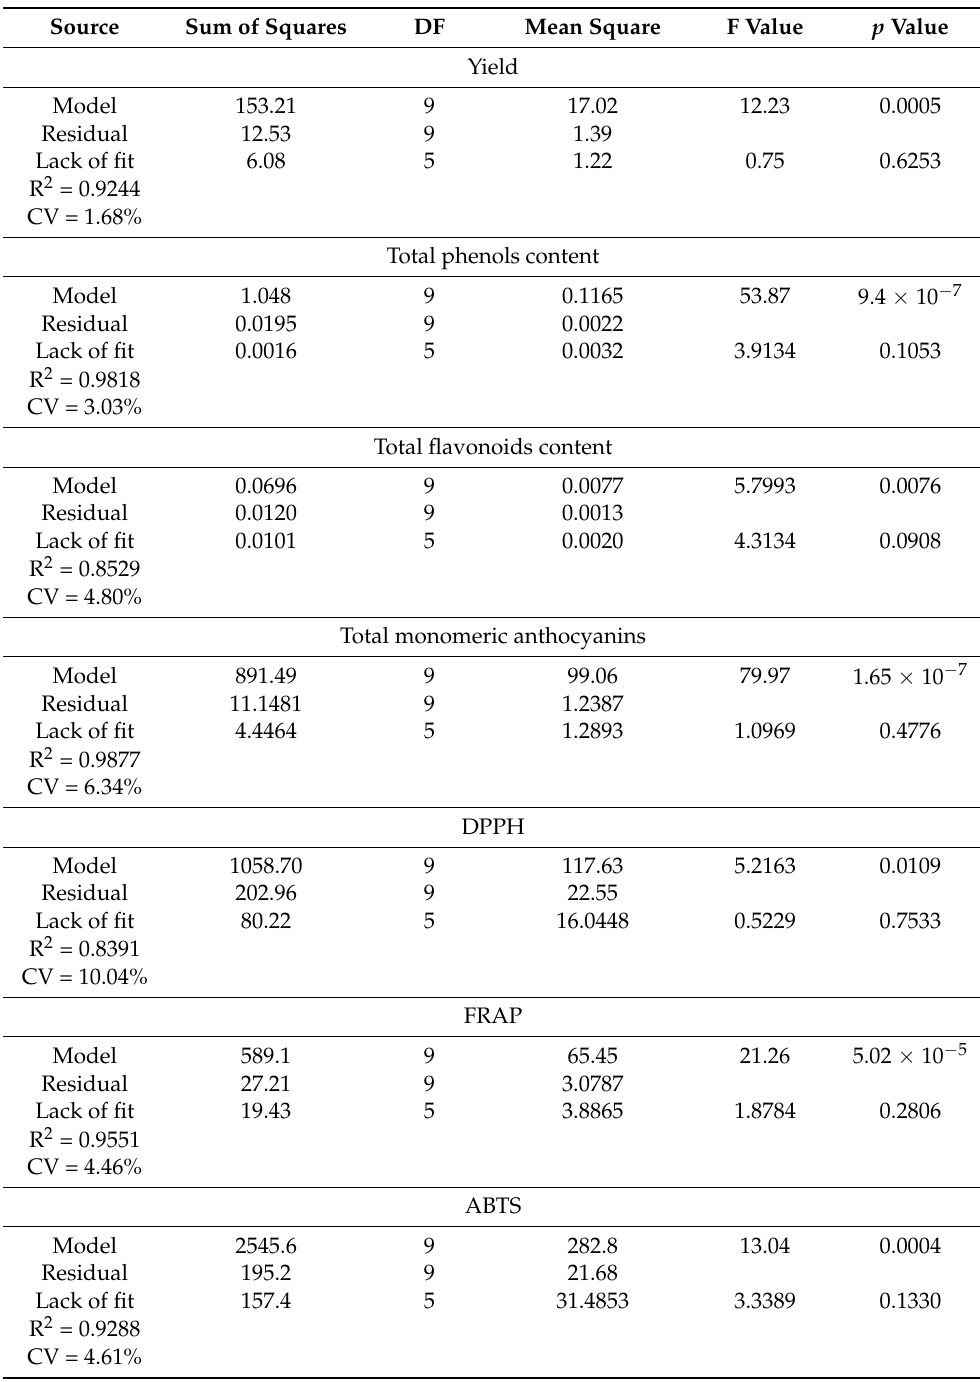
Table 3. ANOVA for fitting experimental data with second-order polynomial